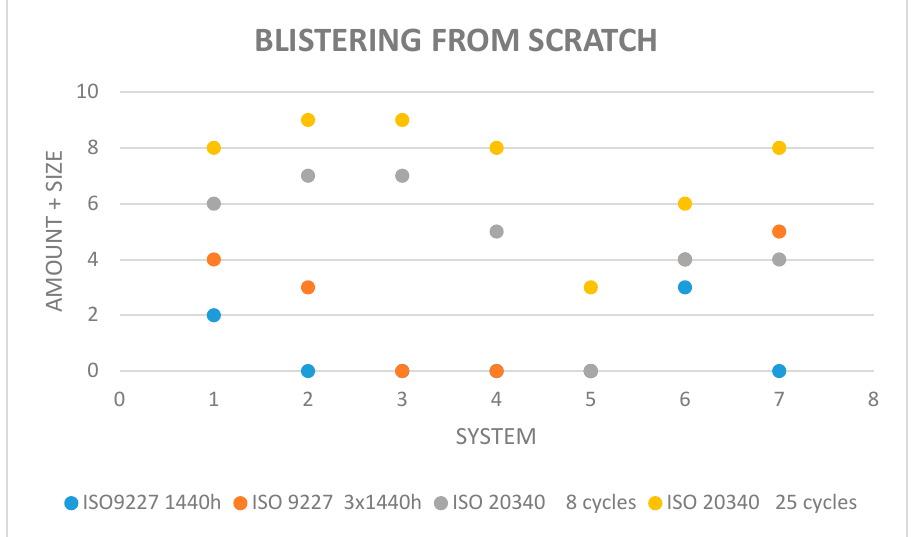
Figure 6. Blistering from the scratch measured according to ISO 4628 ‐ 8:2012 [8].